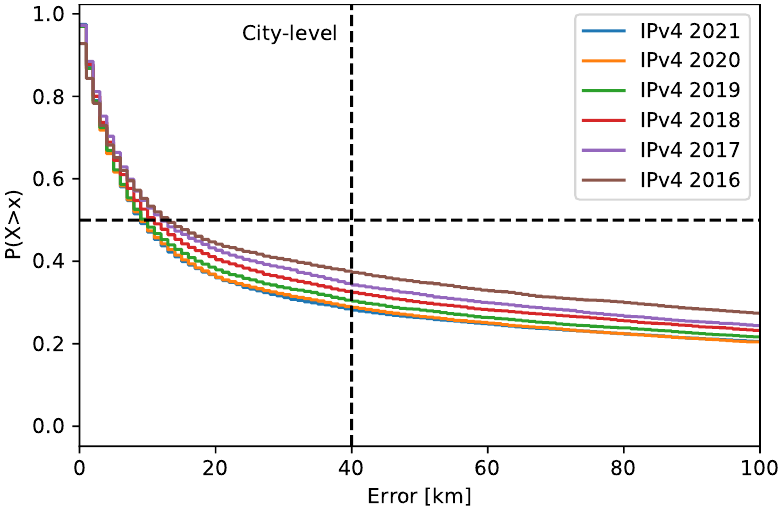
Figure 6. Past IP addresses location by historical databases. IPv4 addresses were dated from 2016. IPv6 addresses were dated from 2018.